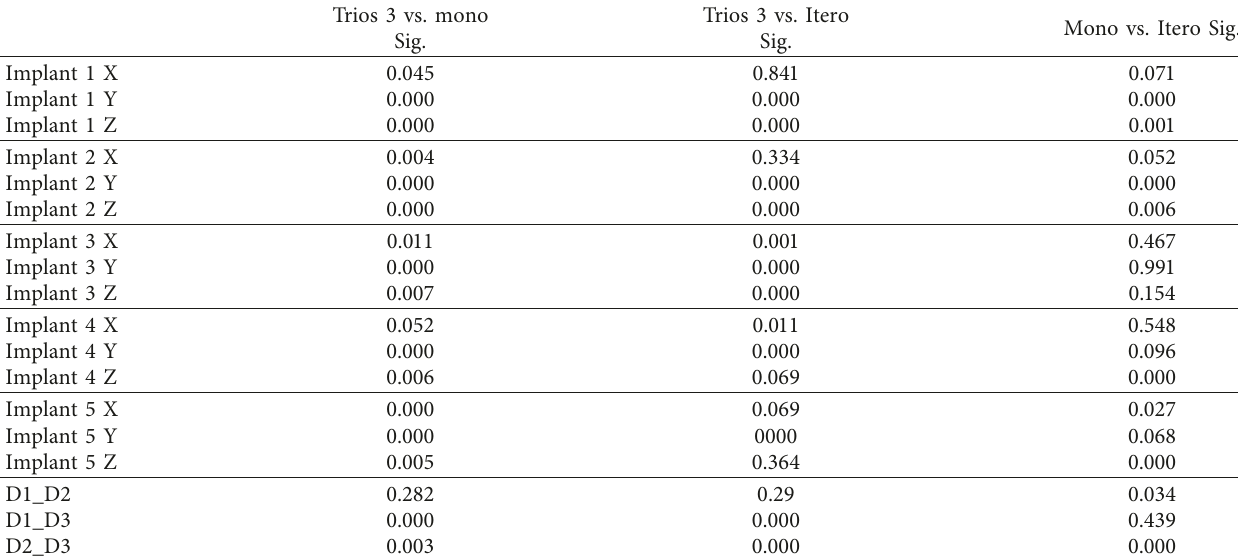
Mono vs. Itero Sig.